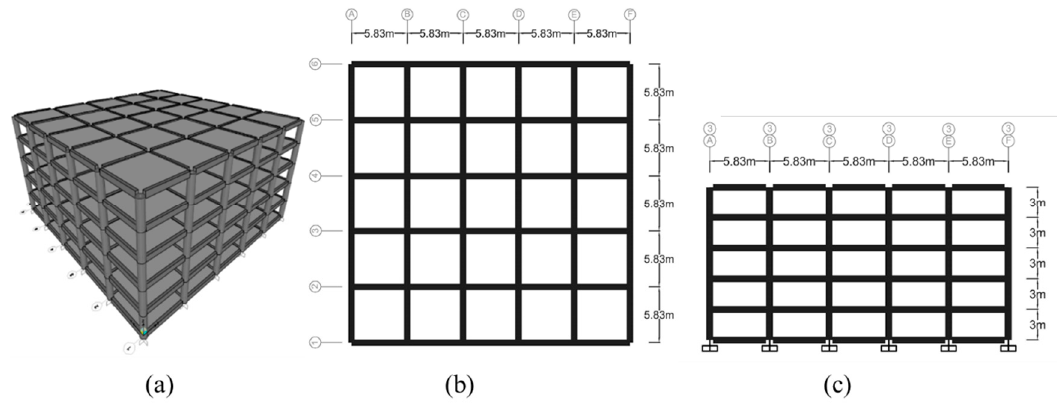
Figure 2. Proposed building ( a ) three-dimensional, ( b ) plan, and ( c ) elevation